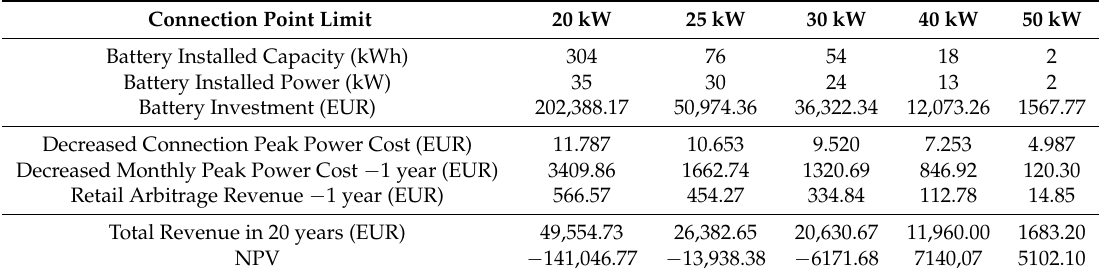
Table 10. Results of optimal battery collocation with an EV charging point for different connection power